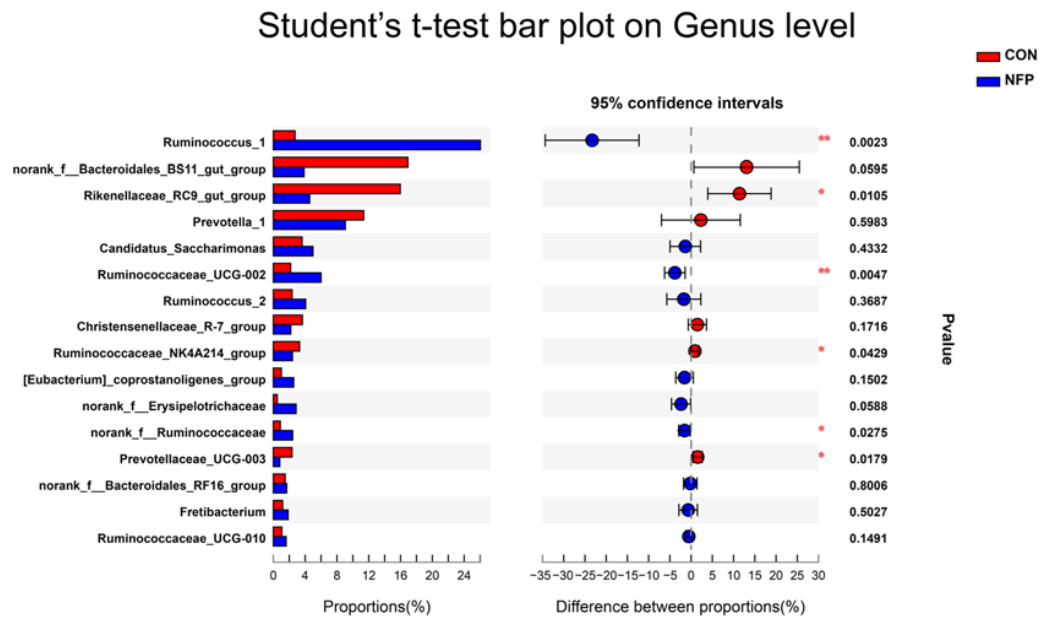
Figure 6. Statistical analysis of different bacterial taxa at the genus level by Student’s t ‐ test in Exp. 2 (* 0.01 < p ≤ 0.05, ** 0.001 < p ≤ 0.01) . Table 8. Relative abundance of main bacterial phyla and genera in Exp. 2.